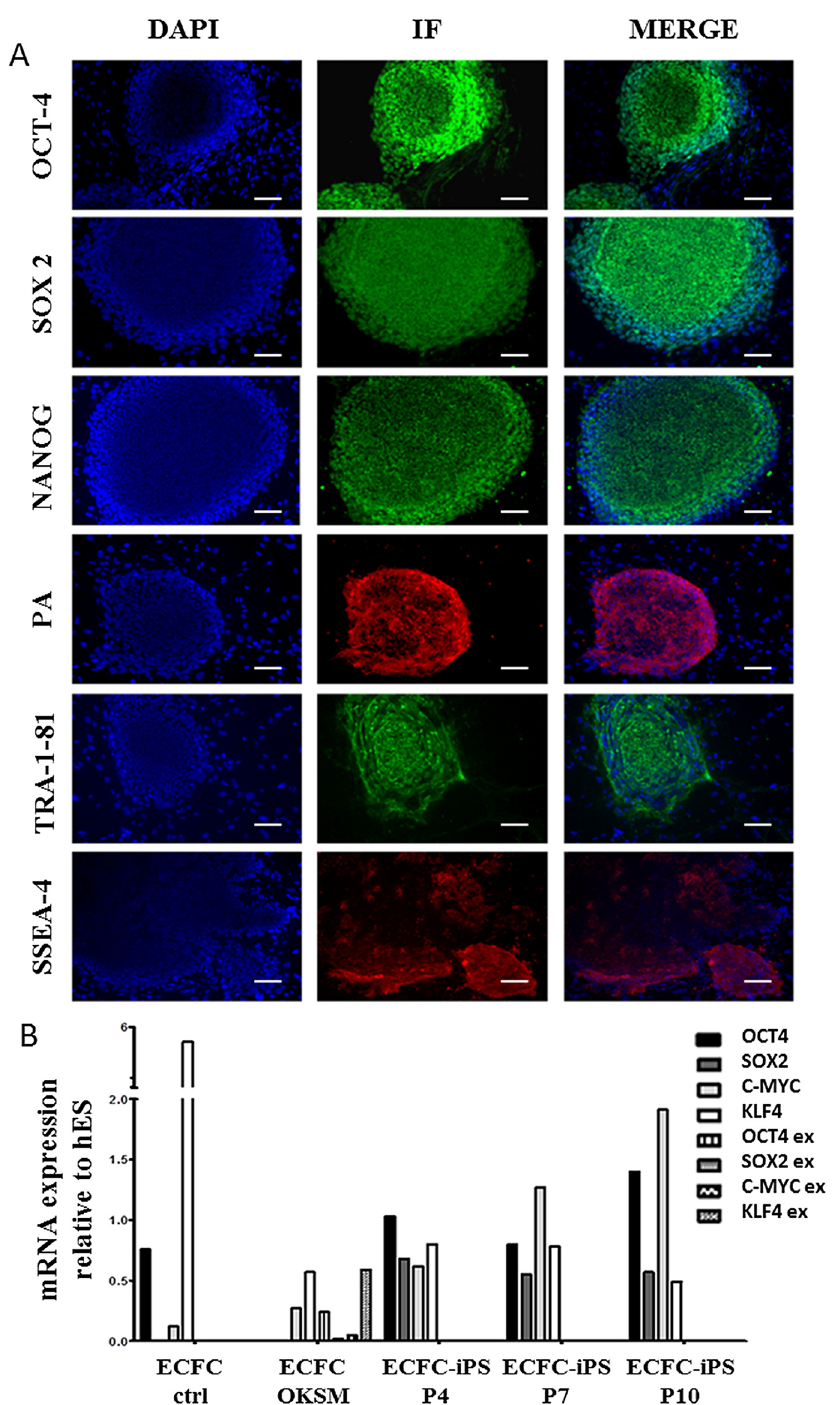
Fig 3. ECFC-derived iPSCs express typical hESC markers. (A) Immunofluorescence analysis of ECFC- derived iPSC1 line. Expression of stem cell markers: OCT3/4, SOX2, NANOG, PA, SSEA4, TRA-1-81. The cells were stained using the 488 and 546-conjugated Donkey Anti-Goat IgG or Goat Anti-Mouse IgG secondary antibody and the nuclei were counterstained with DAPI (blue). Scale bars represent 100 μ m. (B) Quantitative RT-PCR analysis of the expression of endogenous (endo) and exogenous (exo) markers: OCT3/4 , SOX2 , KLF4 and C-MYC in Ctrl ECFCs, transduced ECFCs (ECFC OKSM) and ECFC-derived